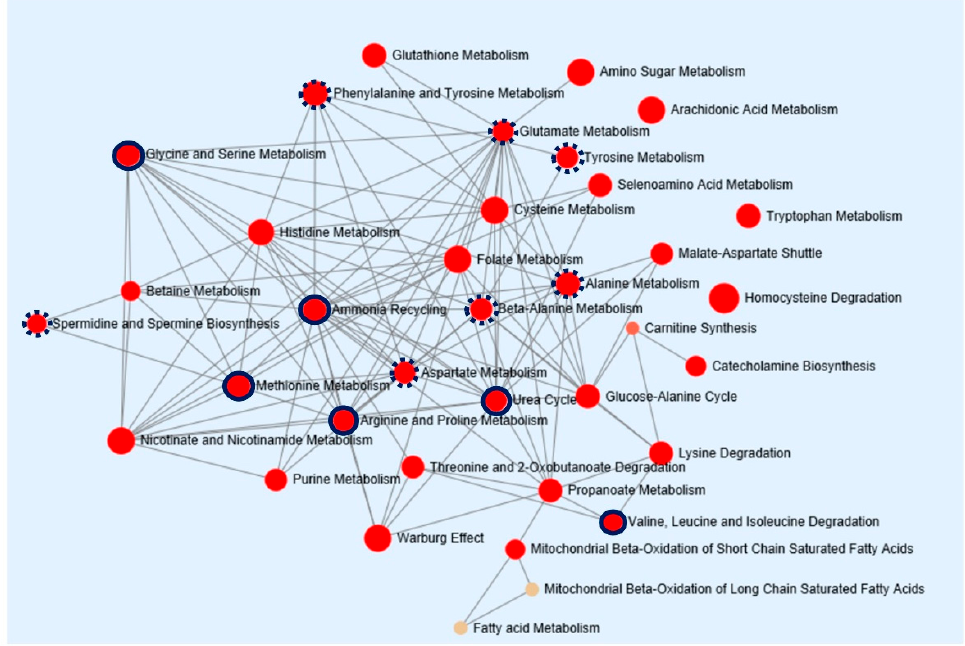
Figure 4. Pathway enrichment analysis of metabolic biomarkers in HCC. The network map represents pathways strongly correlated to metabolic dysfunction in HCC. Enrichment pathway analysis was based on the Kyoto Encyclopedia of Genes and Genomes database. All the represented metabolic pathways have FDR-adjusted p -values of less than 0.001. The sizes of the red circle indicate fold enrichment. Solid and dotted red circles represent metabolic pathways with more than four and three metabolic hits, respectively. HCC, hepatocellular carcinoma; FDR, false discovery rate.